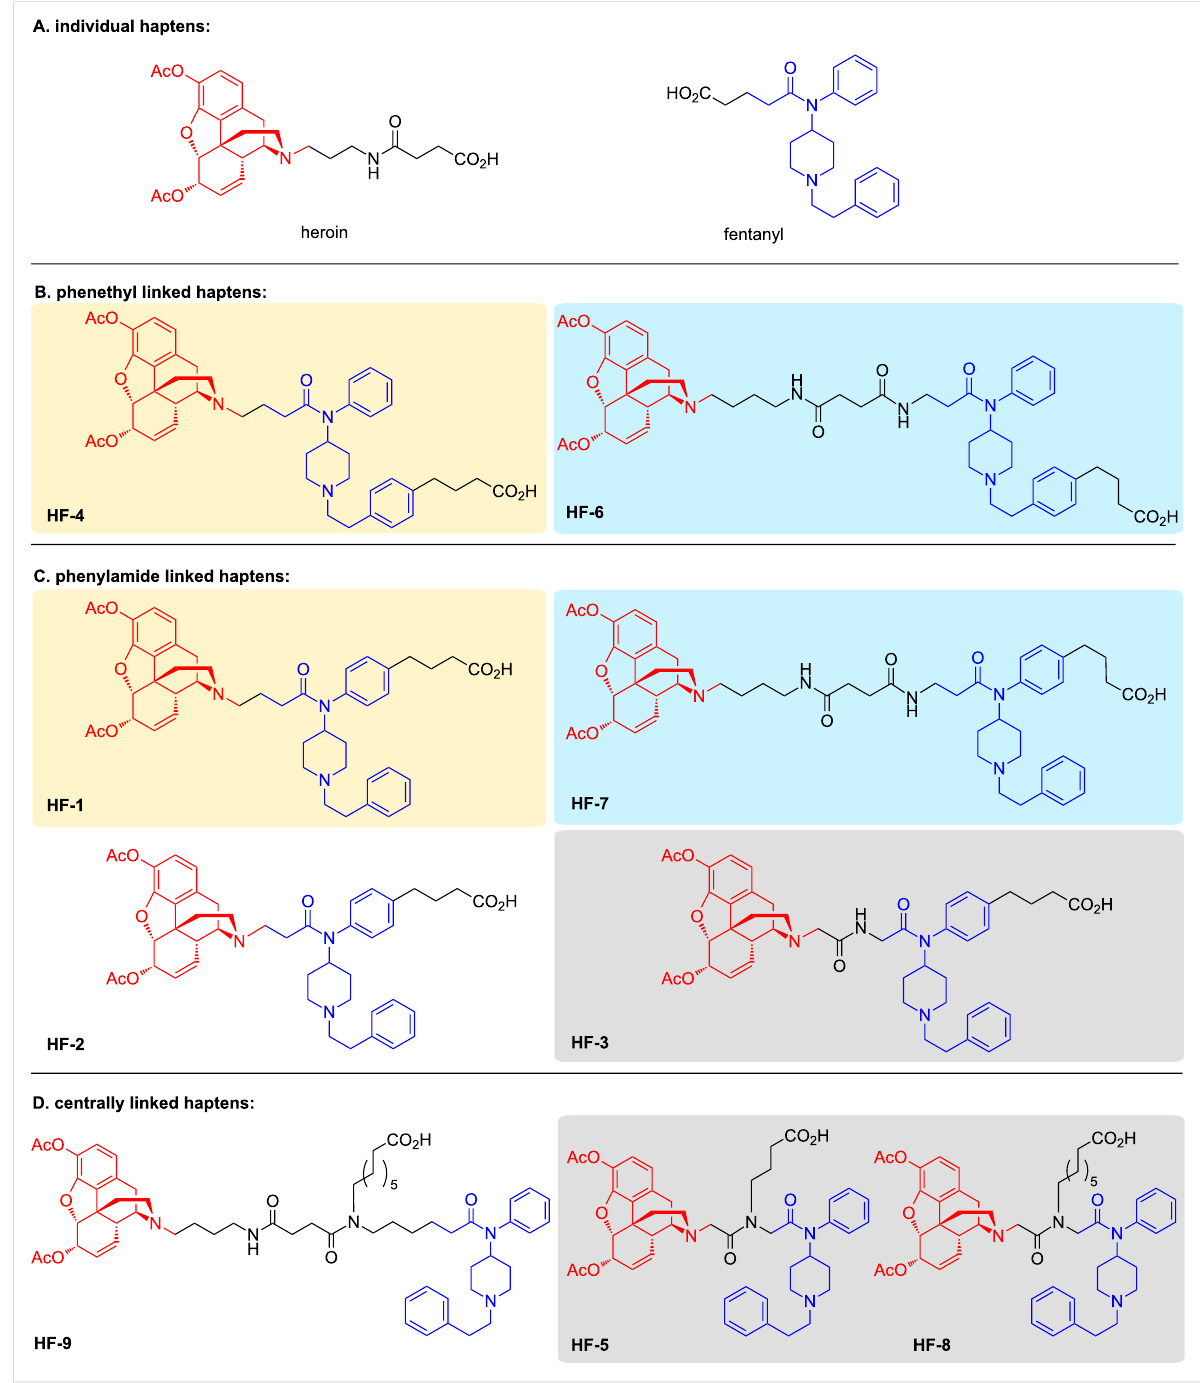
Figure 2: The chemically contiguous heroin–fentanyl haptens designed in this study. Grouping was based on the linker-carrier protein attachment. A) The individual drug haptens with an acid moiety for hapten-carrier protein attachment. B) Haptens to be linked to the carrier protein at the 4-posi- tion on the phenyethyl group. C) Drug haptens to be attached to the carrier protein para to the phenylamide. D) Haptens conjoined centrally between each drug hapten. Background color indicates haptens with structurally identical epitopes. Heroin and fentanyl molecules are highlighted in red and blue, respectively, in the hapten